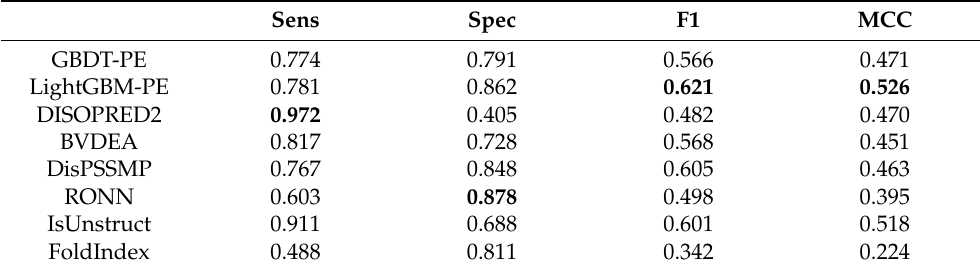
Table 8. Prediction performance comparison based on test set